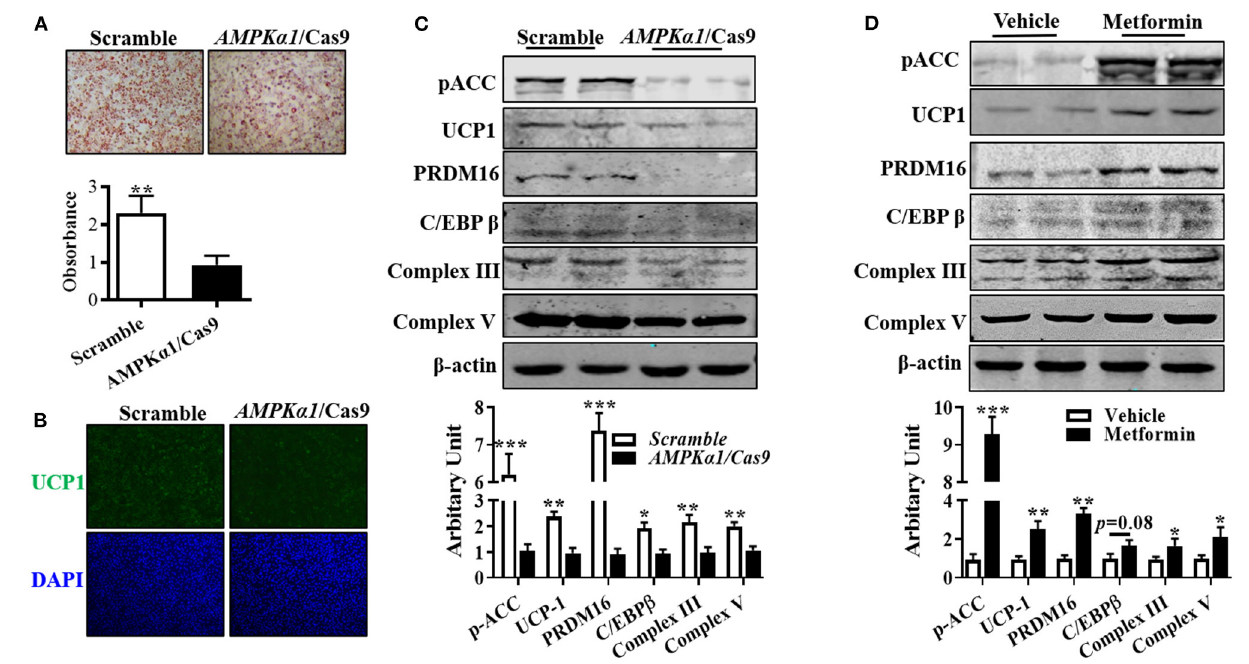
FIGURE 4 | AMPK α 1 activity was necessary for brown adipocyte formation. Precursor cells were transfected with either scrambled Cas9 or AMPK α 1 CRISPR/Cas9 and induced brown adipogenesis. (A,B) Adipocytes were visualized by oil-red O staining (A) and immunocytochemistry staining of UCP1 after 6 days of differentiation (B) . (C,D) Protein abundances of p-ACC, UCP1, PRDM16, C/EBP β , complex III, and complex V. Cells were treated with metformin (2mM) and vehicle, and protein contents of p-ACC, UCP1, PRDM16, C/EBP β , complex III, and complex V were analyzed using Western blotting ( n = 6, mean ± SEM; * P < 0.05, ** P < 0.01, *** P <